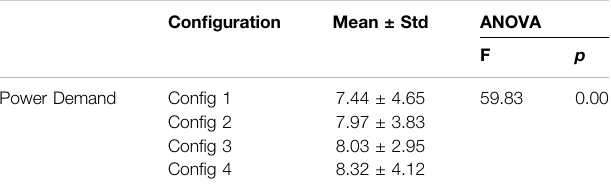
TABLE 2 | Statistical analysis of Power demand of C-LREX in each con fi guration.